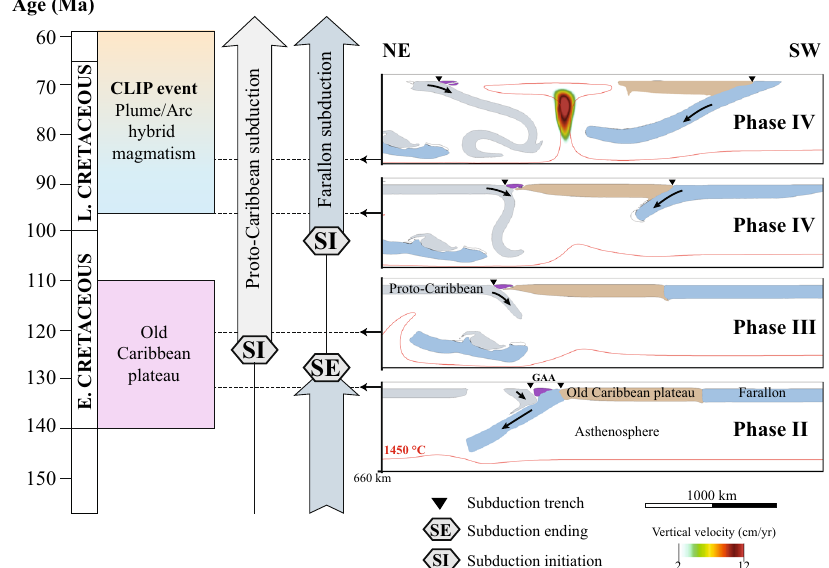
Fig. 4 | Timeline of the main Cretaceous Caribbean tectono-magmatic events compared with the reference simulation. The 4 cross-sections shown in this fi gure are slices performed 100km away from the northern boundary of the 3D simulation. Subduction-initiation induced plume during phase IV is depicted by overlaying the vertical velocity fi eld. Note that during phase IV the Caribbean pla- teau is thinning due to extensional forces as suggested by previous studies 11,18